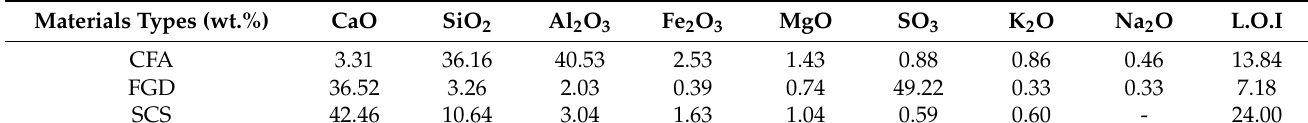
Table 1. Chemical compositions of raw materials (wt.%).